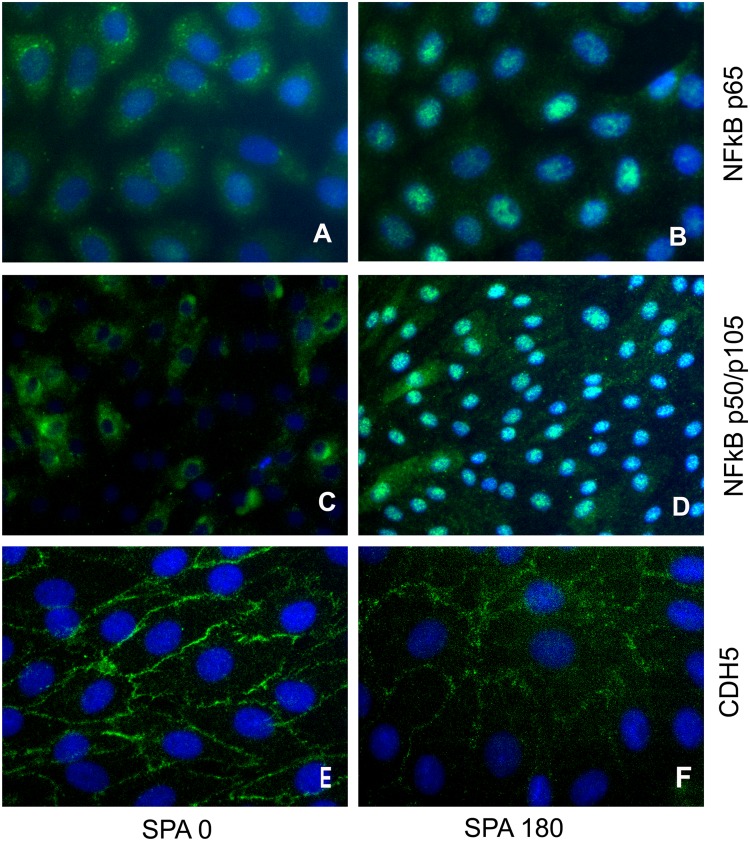
SPA modulates localization of NFKB p105/p50, NFKB p65 and CDH5.BAEC were exposed to asynchronous or synchornous condition for 7h. Stainings for NFKB p105/p50 (B) and p65 (D) were localized in the citoplasm and the nucleos for EC exposed to SPA = -180. NFKB localization where entirely citoplasmatic for EC exposed to SPA = 0 (A, C). The distribution for CDH5 were continous around the entire periphery of the cells after 7 when cells where exposed to SPA = 0 (E). Exposure of EC to SPA = -180 for 7 hours resulted in an intermitted pattern of CDH5 (F). images showed here are representative resutl from 3 individual experiments.